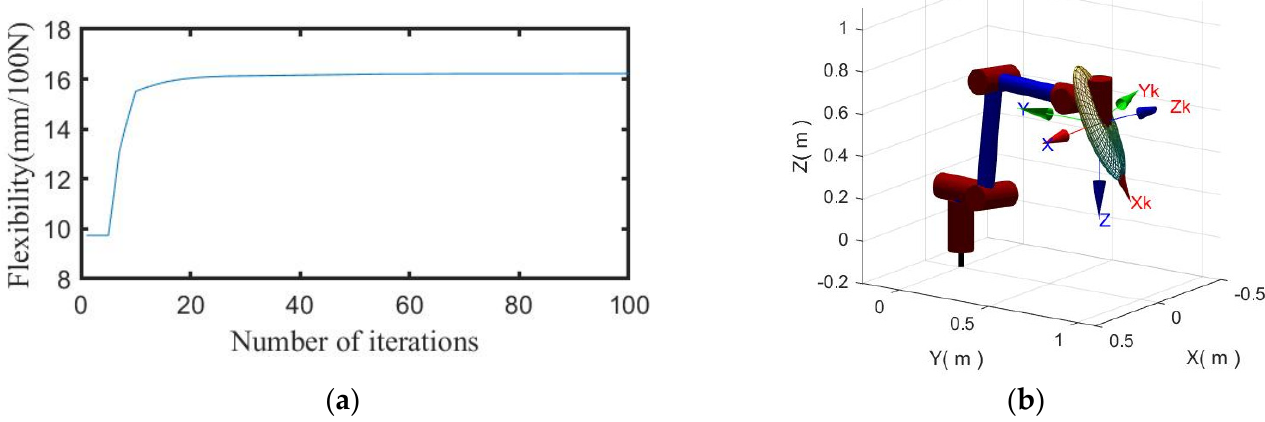
Figure 7. Disturbance of the base in experiment 1.